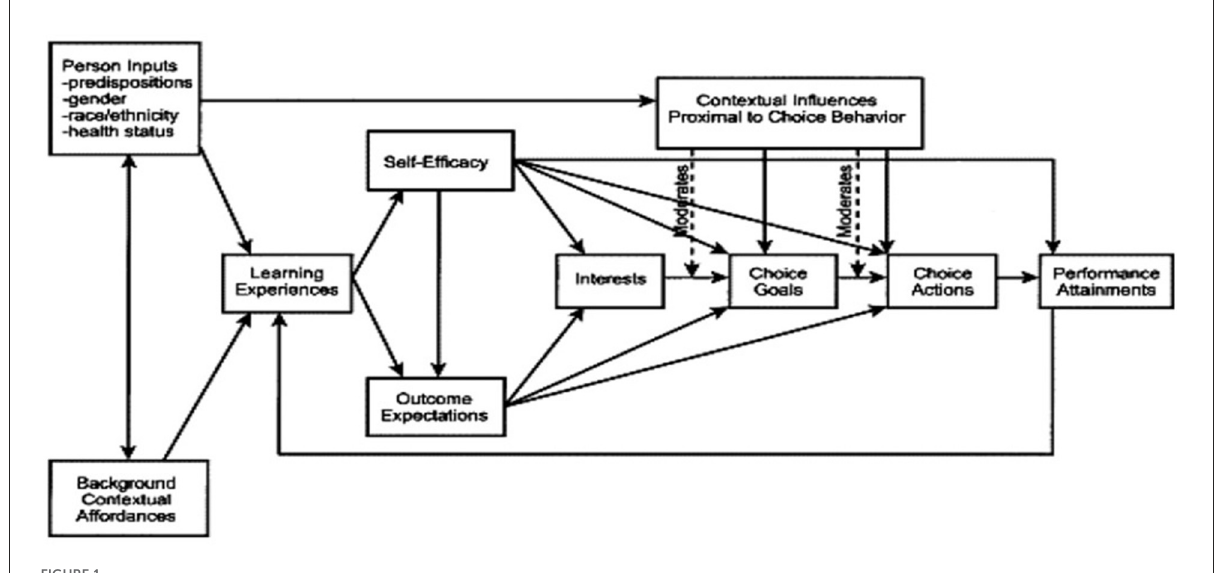
FIGURE1 Social cognitive career